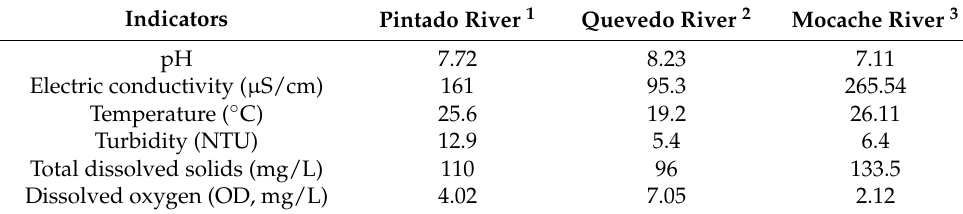
Table 1. Water characteristics in the three rivers of Guayas basin.